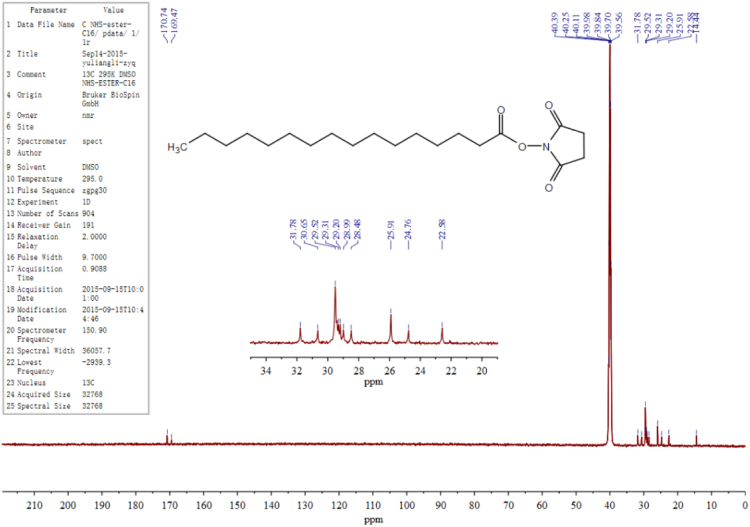
13C NMR spectrum of C16-NHS.